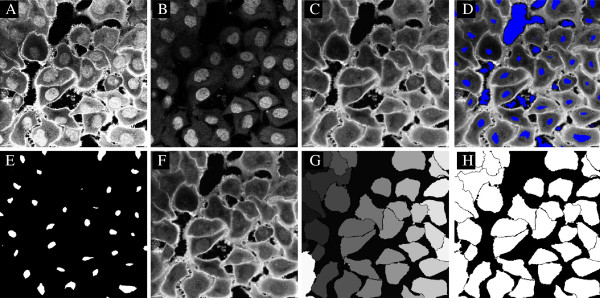
Segmentation of cells using nucleus markers in 3D from Example 8, visualized for plane two. A) Raw surface stain, B) raw nucleus stain, C) surface stain minus nucleus stain, D) markers (blue) from nucleus stain superimposed on the surface stain, E) cell markers, F) smoothed input image, from C, G) watershed image, H) detected cells. All cells have been detected.